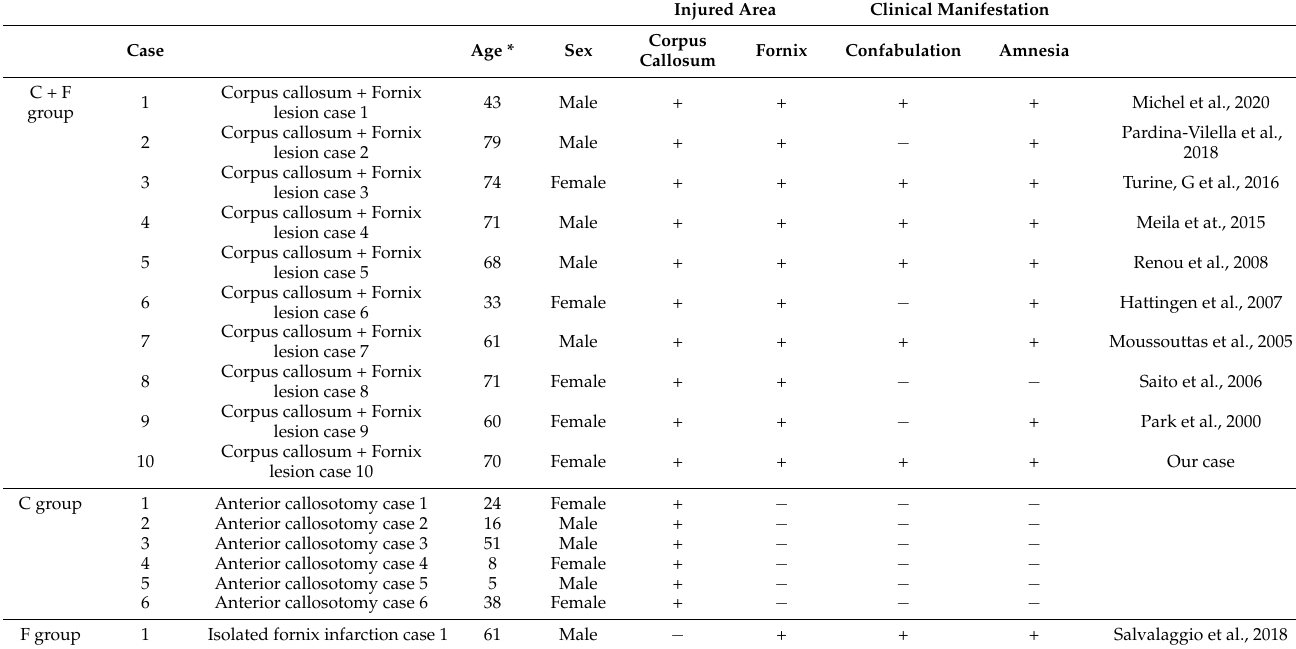
Table 1. Collected